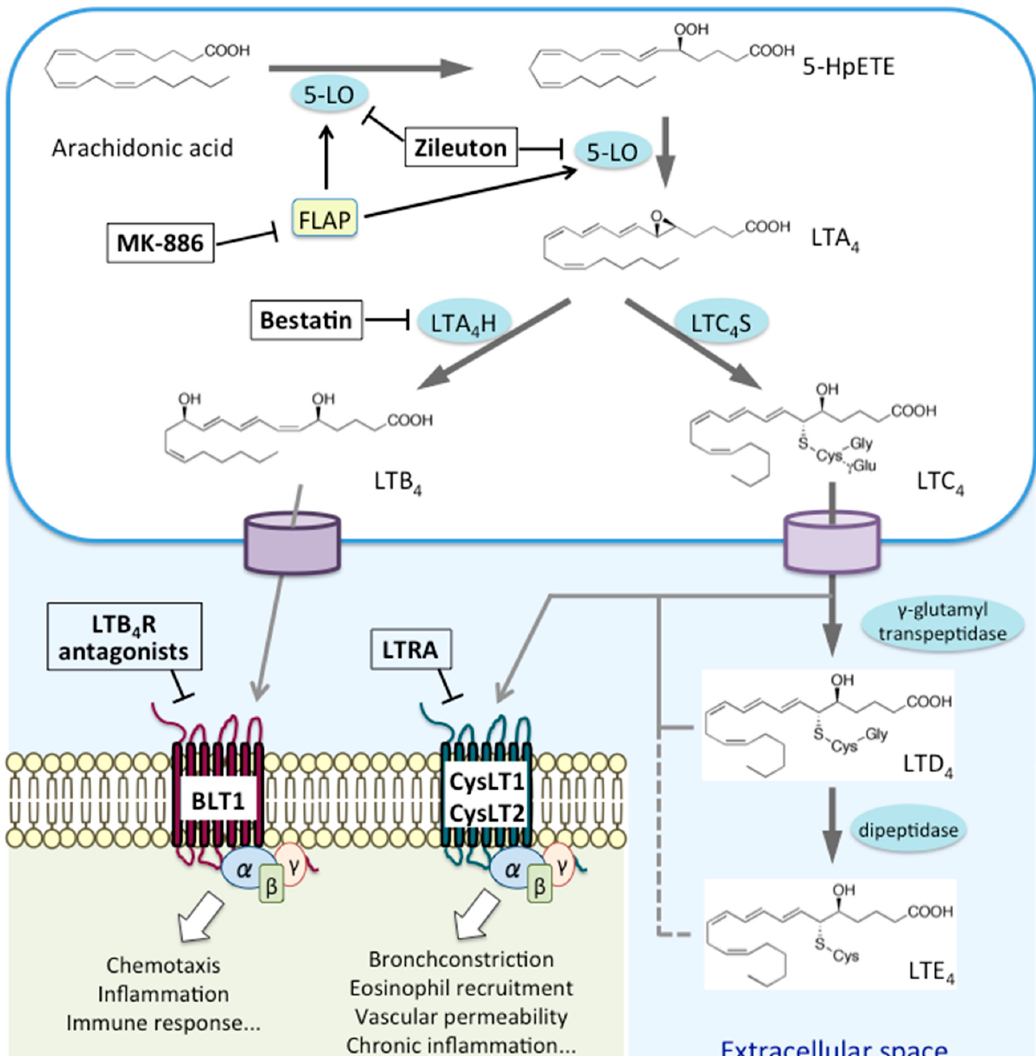
Figure 1. Biosynthetic pathways and receptors for leukotrienes.